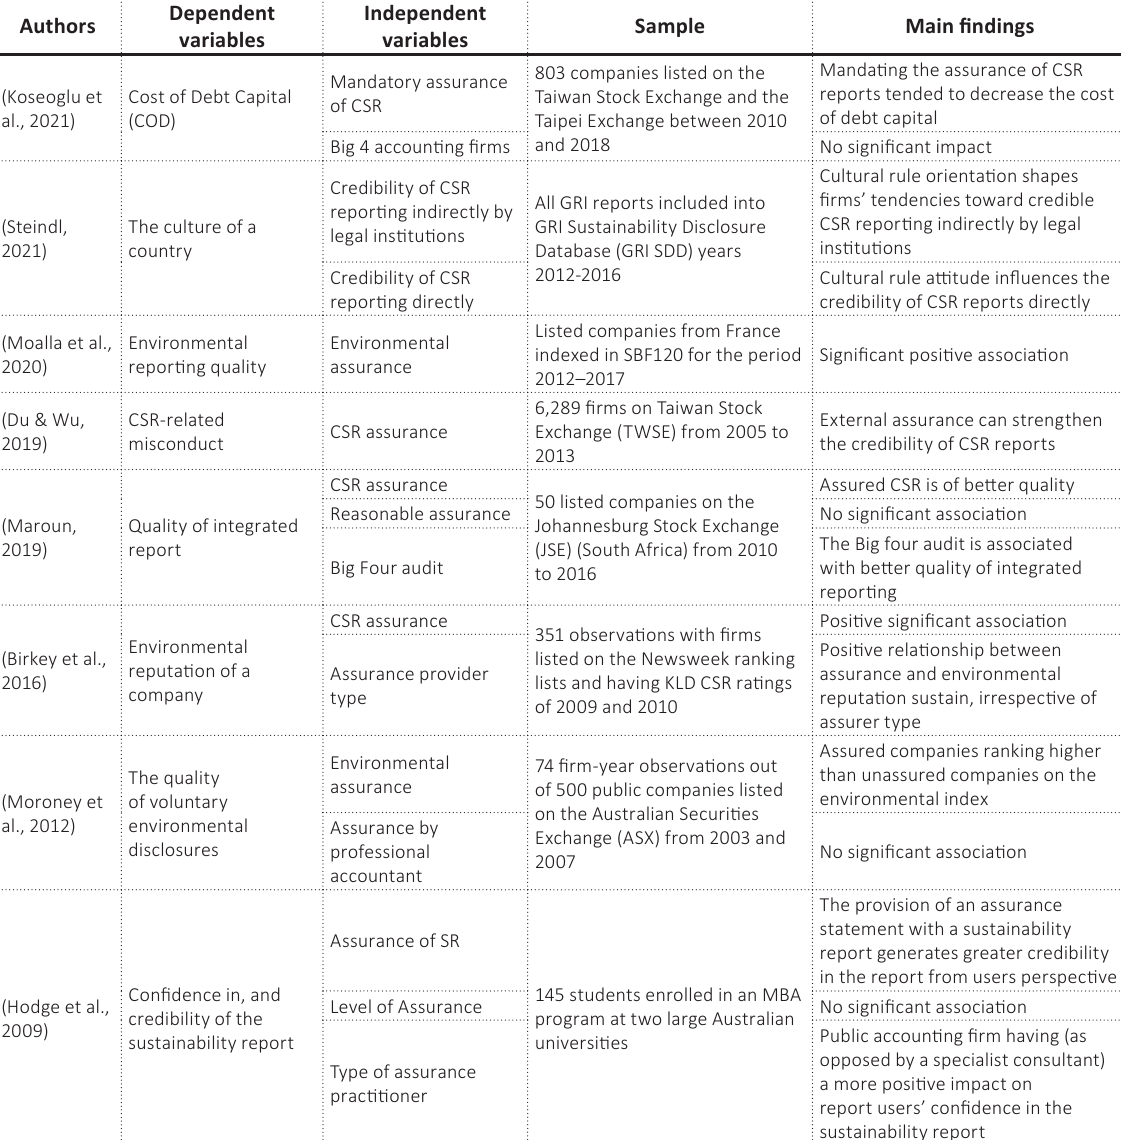
Table A1. Prior studies on the effect of CSRA on CSRR quality*